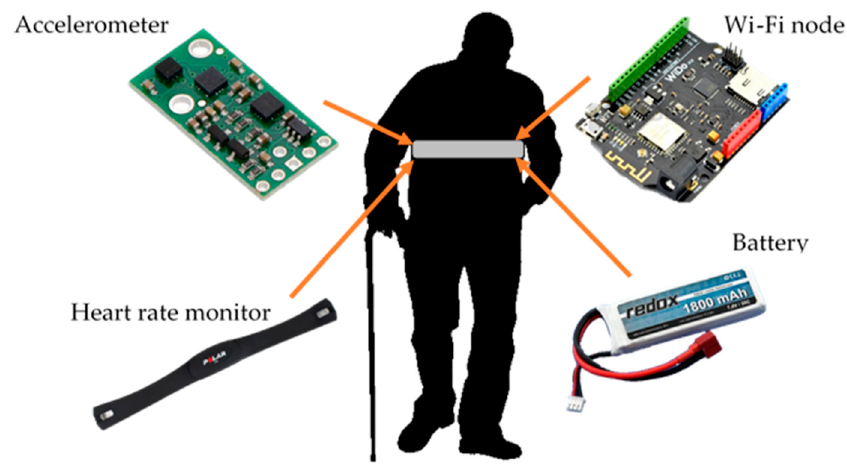
Figure 6. Component setup of the designed system prototype [41].